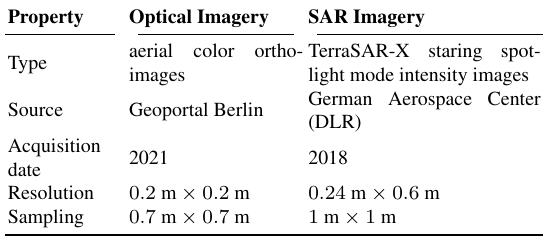
Table 1. Properties of the remote sensing image data used in this